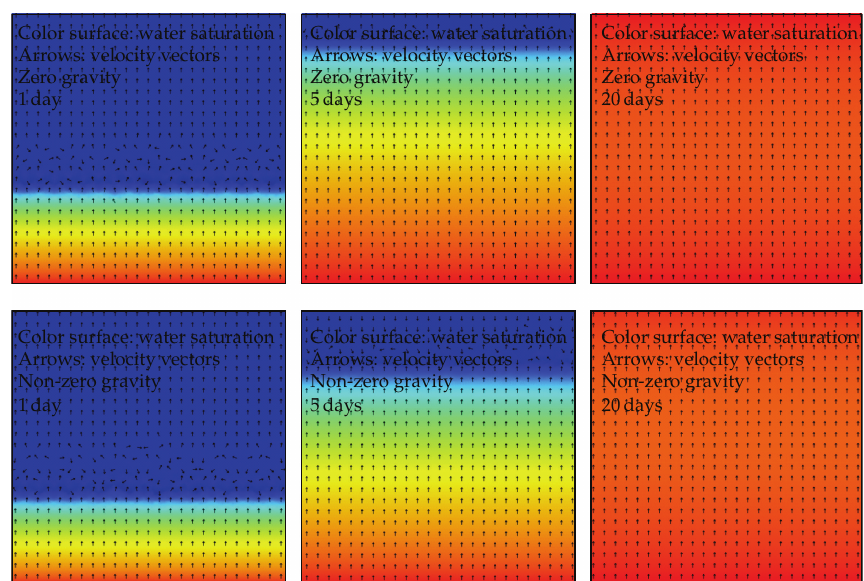
Figure 14: Distributions of water saturation and velocity vectors of zero, nonzero gravity for the bottom- inlet case.